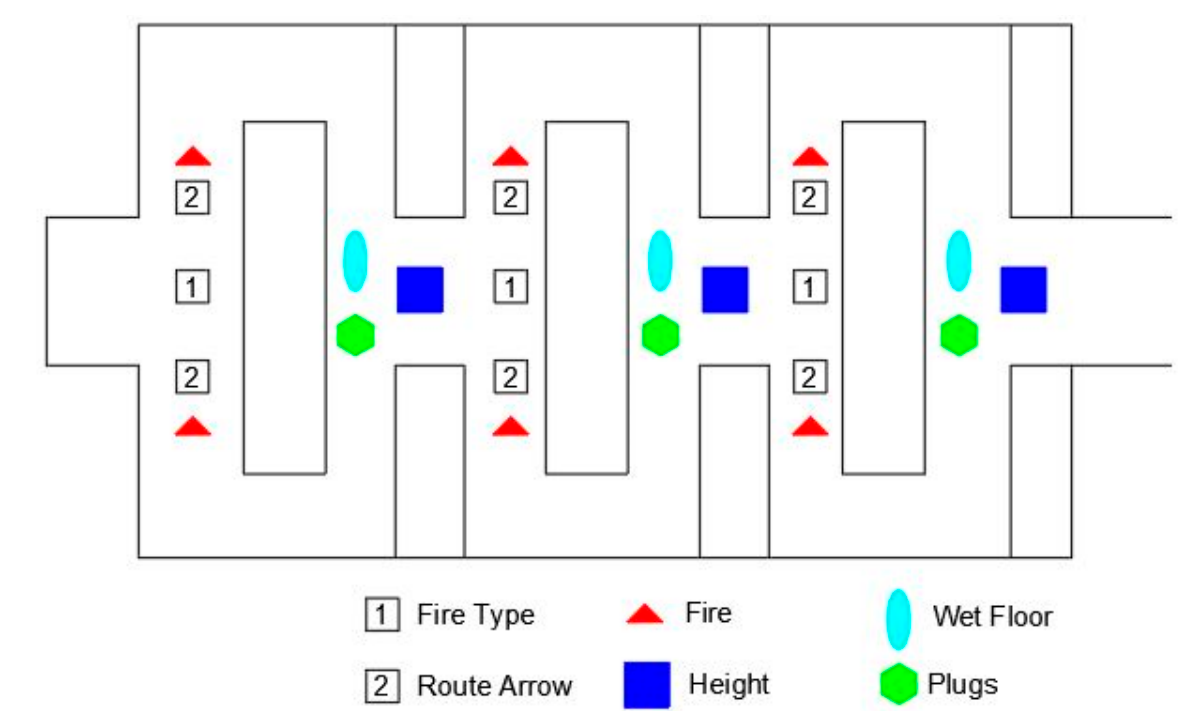
Figure 5. Hazard distribution, route and educational signs in the principal maze.